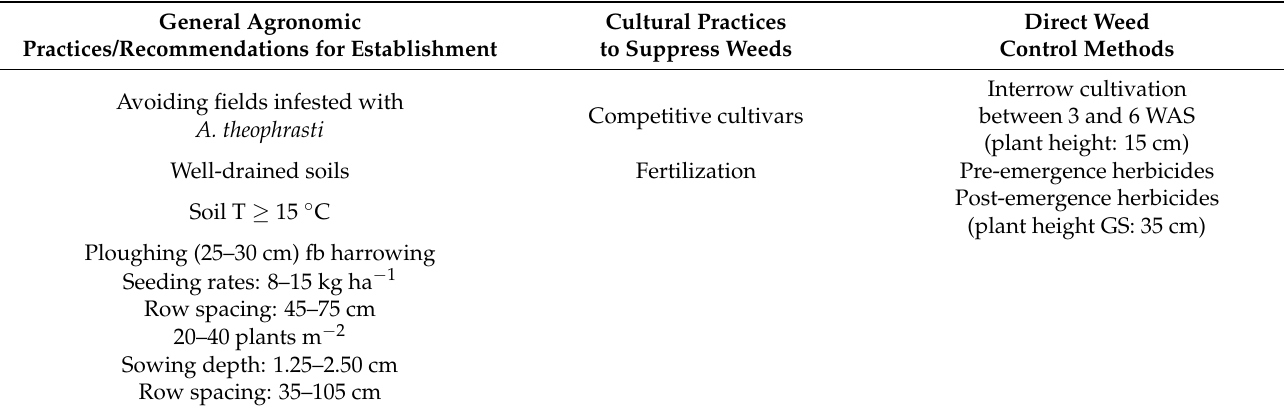
Table 6. General agronomic practices and recommendations for kenaf establishment, cultural practices to suppress weeds and direct weed control